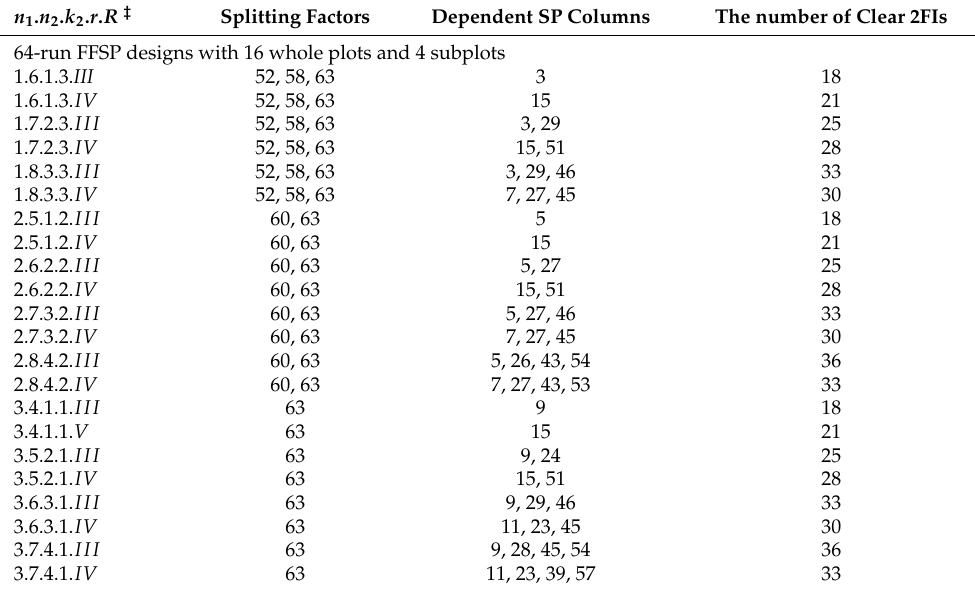
Table 4. Example 64-run FFSP designs with splitting factors which have the most clear 2FIs. n 1 . n 2 . k 2 . r . R ‡ Splitting Factors Dependent SP Columns The number of Clear 2FIs 64-run FFSP designs with 16 whole plots and 4 subplots 1.6.1.3.